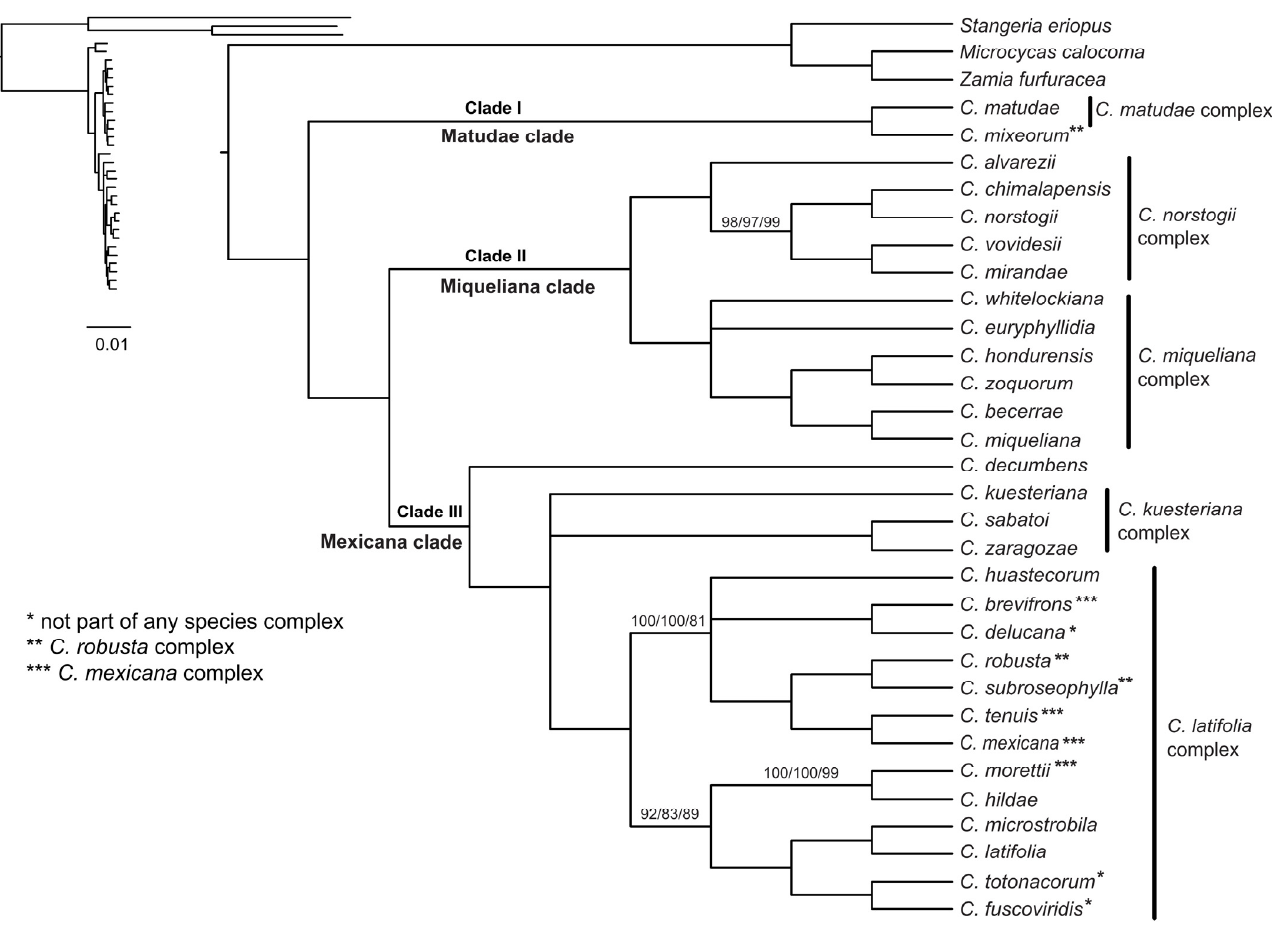
Figure 2. Congruent tree topology of Ceratozamia found by the maximum likelihood (ML) approach from the concatenated dataset of 3954 SCGs for 30 species. Numbers above branches are ML bootstrap (BS) from the nt/nt12/aa dataset, respectively. Only support values < 100% are shown. Branches with BS < 85 are collapsed. Seven species complexes adapted from Vovides [25,37] are marked in context of phylogenetic tree. A phylogram overview is shown in the upper left-hand corner with the scale bar indicating the average number of nucleotide substitutions per site.